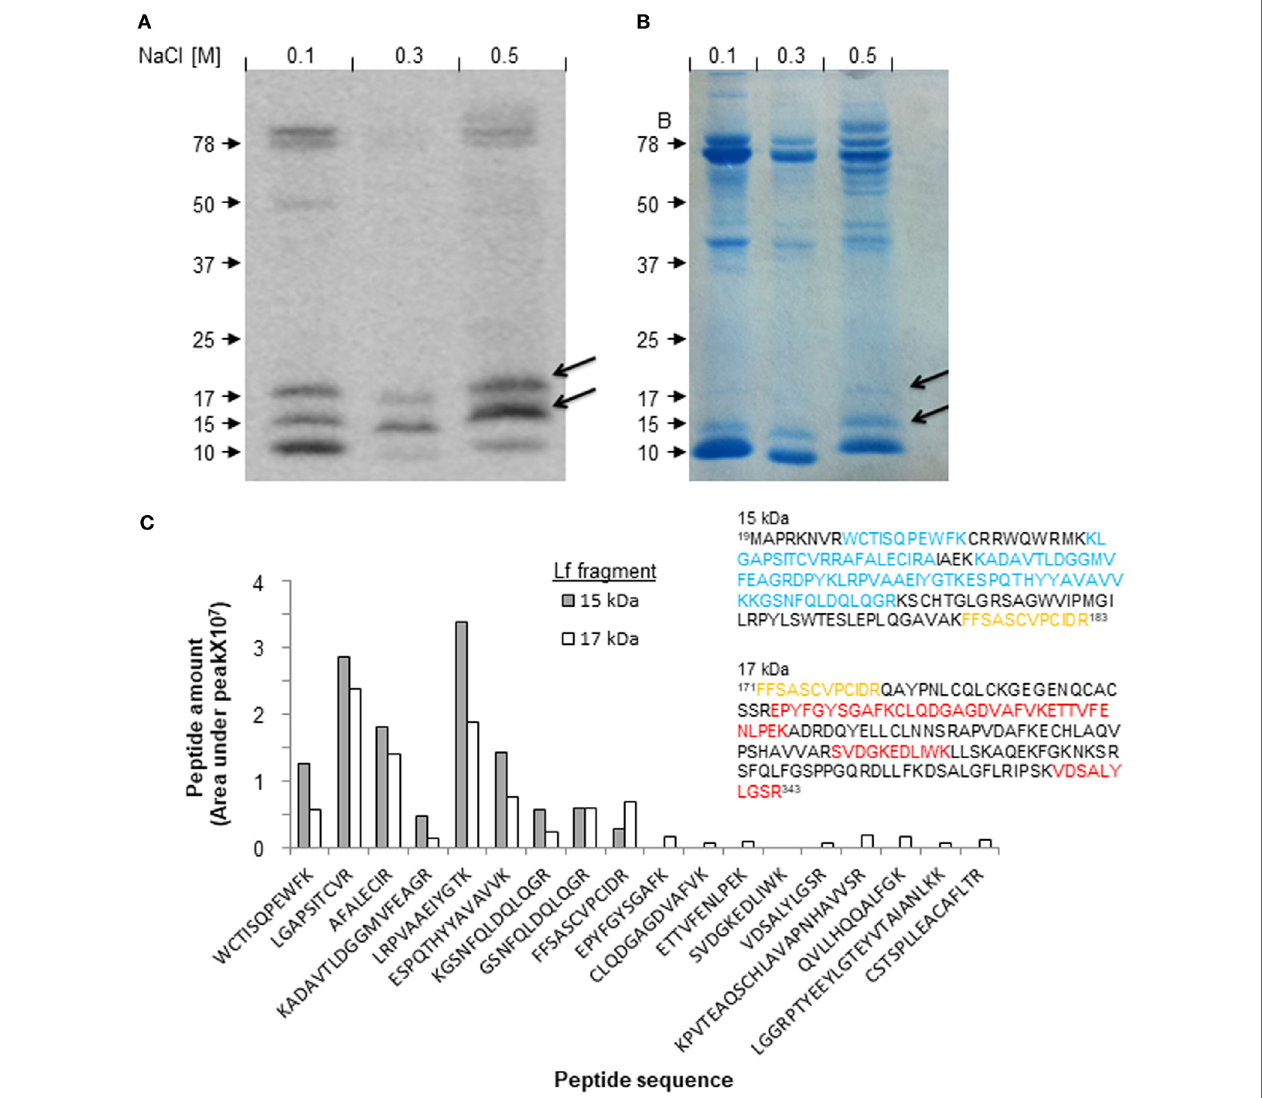
FigUre 2 | Isolation and identification of lactoferrin (Lf)-derived fragments from udders with resolving inflammation. Milk samples from cows with mastitis (day 5, early phase of resolution) were defatted and run on heparin gel columns. The bound proteins and fragments were eluted stepwise with 0.005 M sodium phosphate buffer (pH 6.0) containing 0.1, 0.3, or 0.5 M NaCl. The recovered protein samples were run on 10% sodium dodecyl sulfate-polyacrylamide gel electrophoresis (SDS-PAGE) followed with Western blotting for Lf (a) , and Coomassie Brilliant Blue staining for total protein content (B) . The bands corresponding to the 15- and 17-kDa fragments of Lf were excised from the gel and analyzed by LC-MS-MS. Quantification of the frequency of each fragment was provided by analysis of area under the peak. The indicated fragments were aligned using STRAP software against the full-length Lf sequence taken from the PubMed database. Then, each peptide was associated with the corresponding fragment of 15 or 17 kDa (inset, highlighted in blue and red, respectively). One common peptide present in both fragments is highlighted in orange (c)